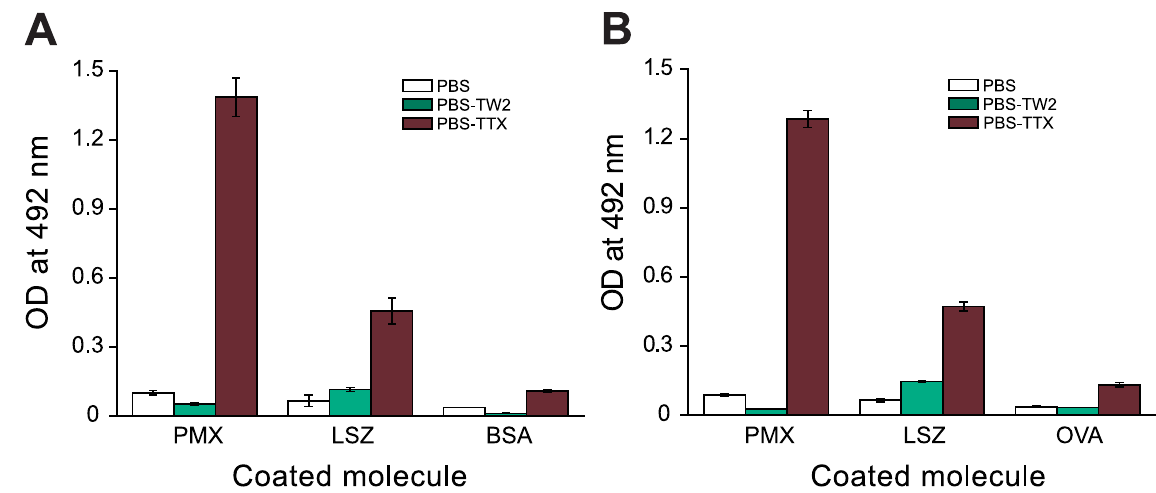
Fig 1. Comparison of LPS binding in indirect ELISA with different buffers and blocking agents. FITC-LPS from E . coli serotype O111:B4 was incubated at 1.25 μ g/ml in PBS-EDTA (PBS), with or without 0.05% Tween 20 (PBS-TW2) or Triton X-100 (PBS-TTX), in wells coated with polymyxin B (PMX) or lysozyme (LSZ) (1 μ g/well), or empty wells (control), which were previously blocked with BSA (A) or OVA (B). Each assay was performed in triplicate. Mean values ± SD are shown in the